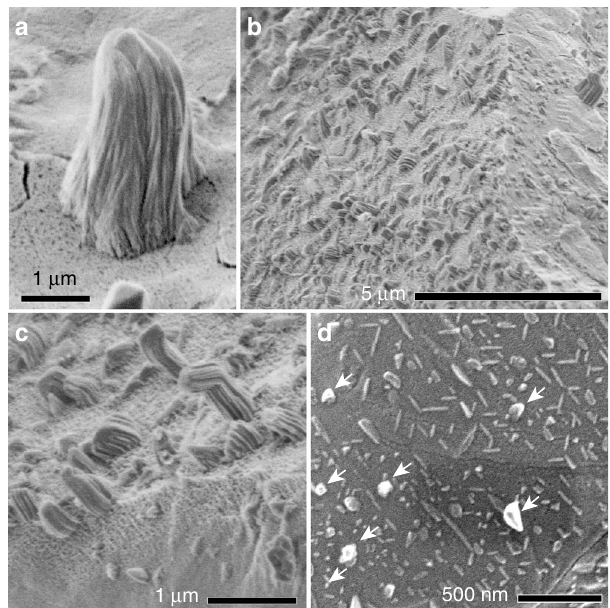
Fig. 1 Surface features of space-exposed troilite in Itokawa samples. a-c Secondary electron (SE) images of whiskers on iron sulphide surfaces at different scales. Dark dots on the iron sulphide surface in ( a ) and ( c ) are open vesicles. A gradual change was observed from a vesicular texture to a non-vesicular texture in ( c ). d SE image of thin plates elongated in speci fi c directions, which apparently correlate with crystallographic directions of the iron sulphide substrate. Whiskers are indicated by arrows. a-c shows surfaces of particle RA-QD02-0325. d is a surface of particle RA-QD02- 0302 (see the sample list in Supplementary Table